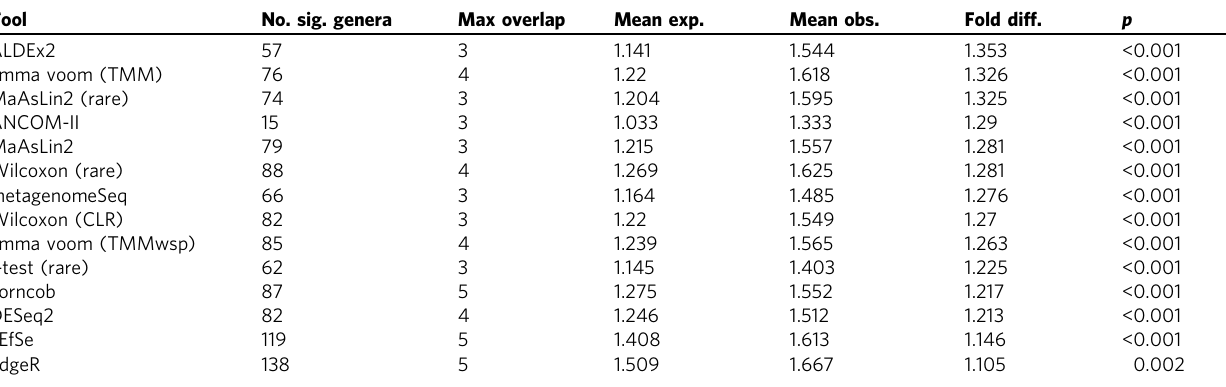
Table 2 Comparison of observed and expected consistency in differentially abundant genera across fi ve diarrhea datasets. Tool No. sig. genera Max overlap Mean exp. Mean obs. Fold